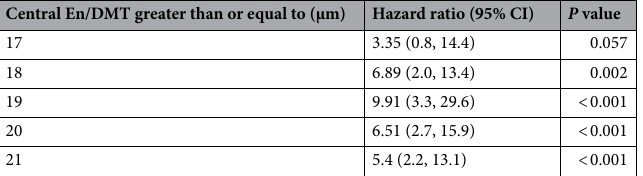
Central En/DMT greater than or equal to